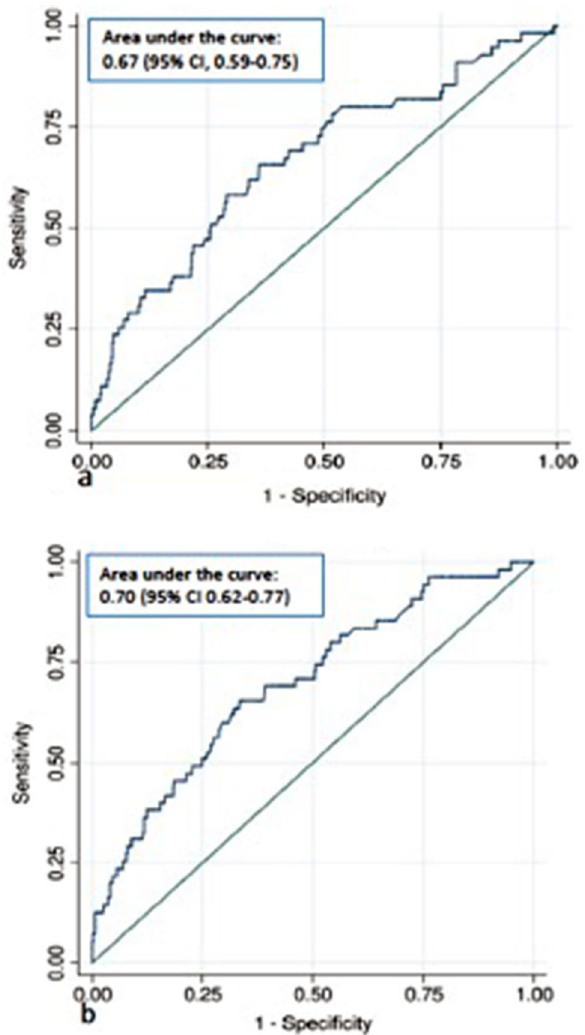
Figure 2. Receiver operating characteristic curve for prediction of shoulder dystocia after attempted operative vaginal delivery according to the prediction model. ( a ) First model without interaction. ( b ) Second model with interaction term with fetal head